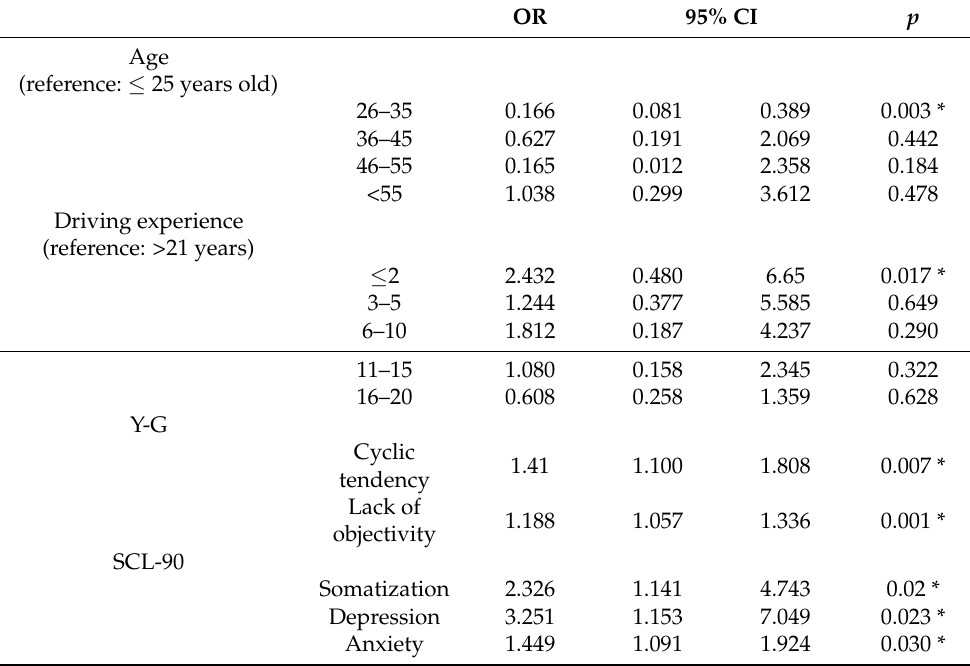
Table 2. Analysis of the risk factors that drivers are prone to traffic accidents. OR 95% CI